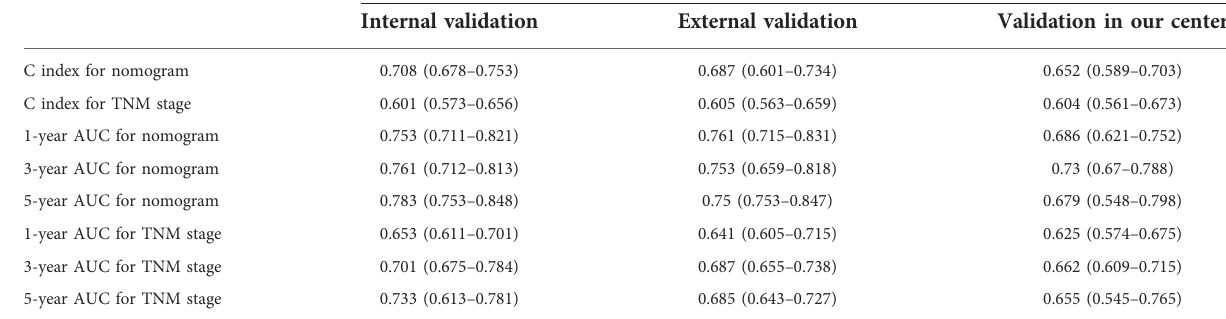
TABLE 3 Prediction accuracy of modi fi ed model vs. TNM stage in survival of ESCC